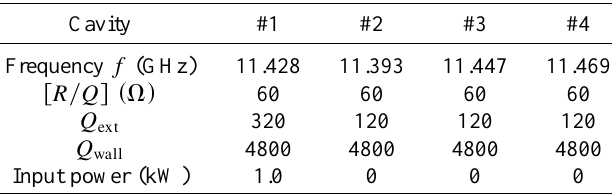
TABLE I. SL4 cavity parameters.